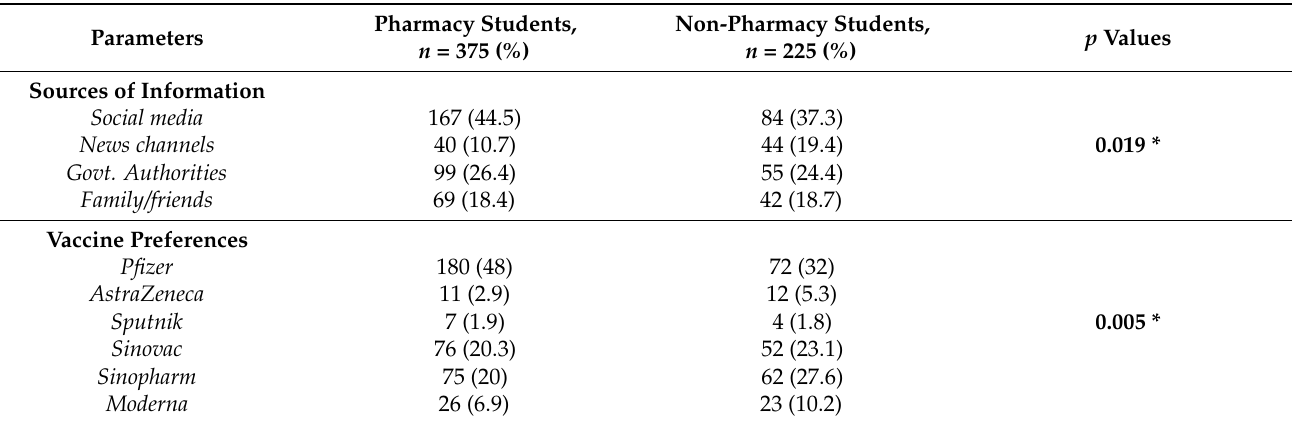
Table 2. Sources of Information and COVID-19 Vaccine Preferences among Pharmacy and Non- pharmacy